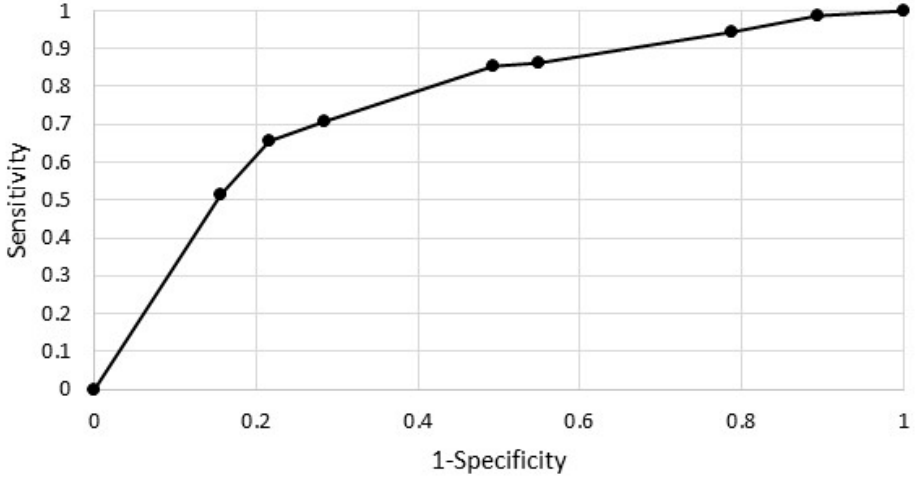
Figure 2. ROC Figure 2. ROC curve.